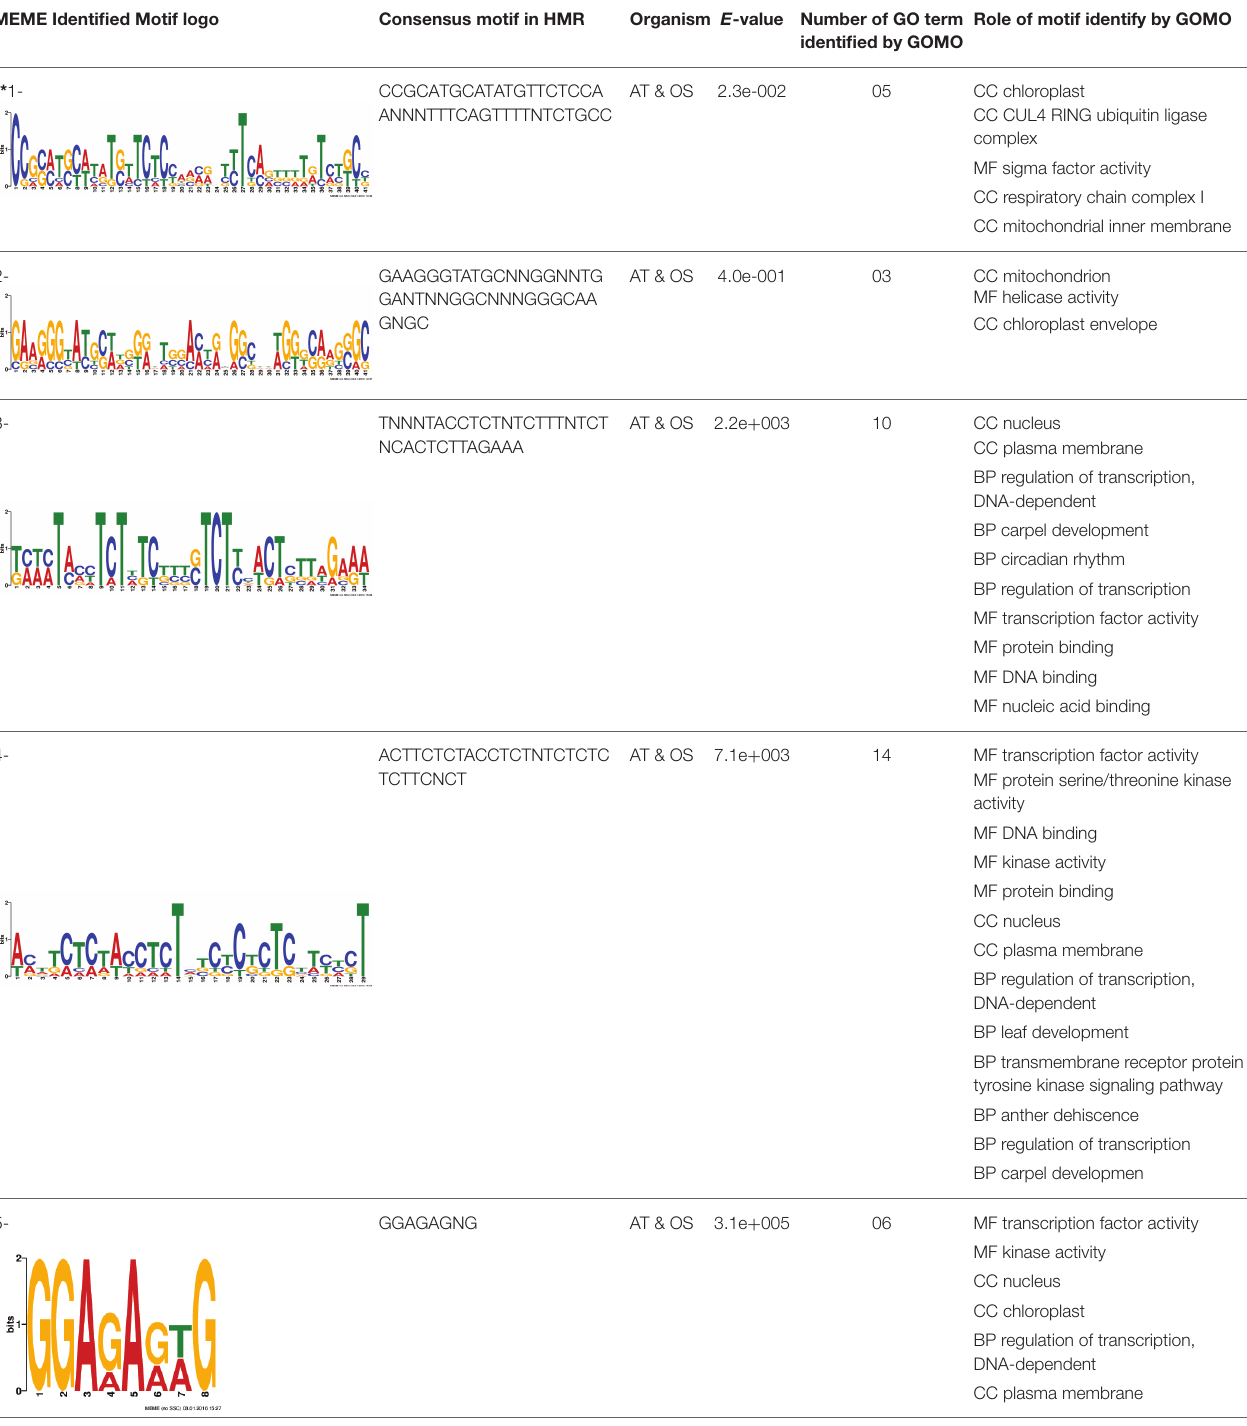
TABLE 6 | Motifs found in of promoter of NMO, CYPs, and GT in the MEME analysis. MEME Identified Motif